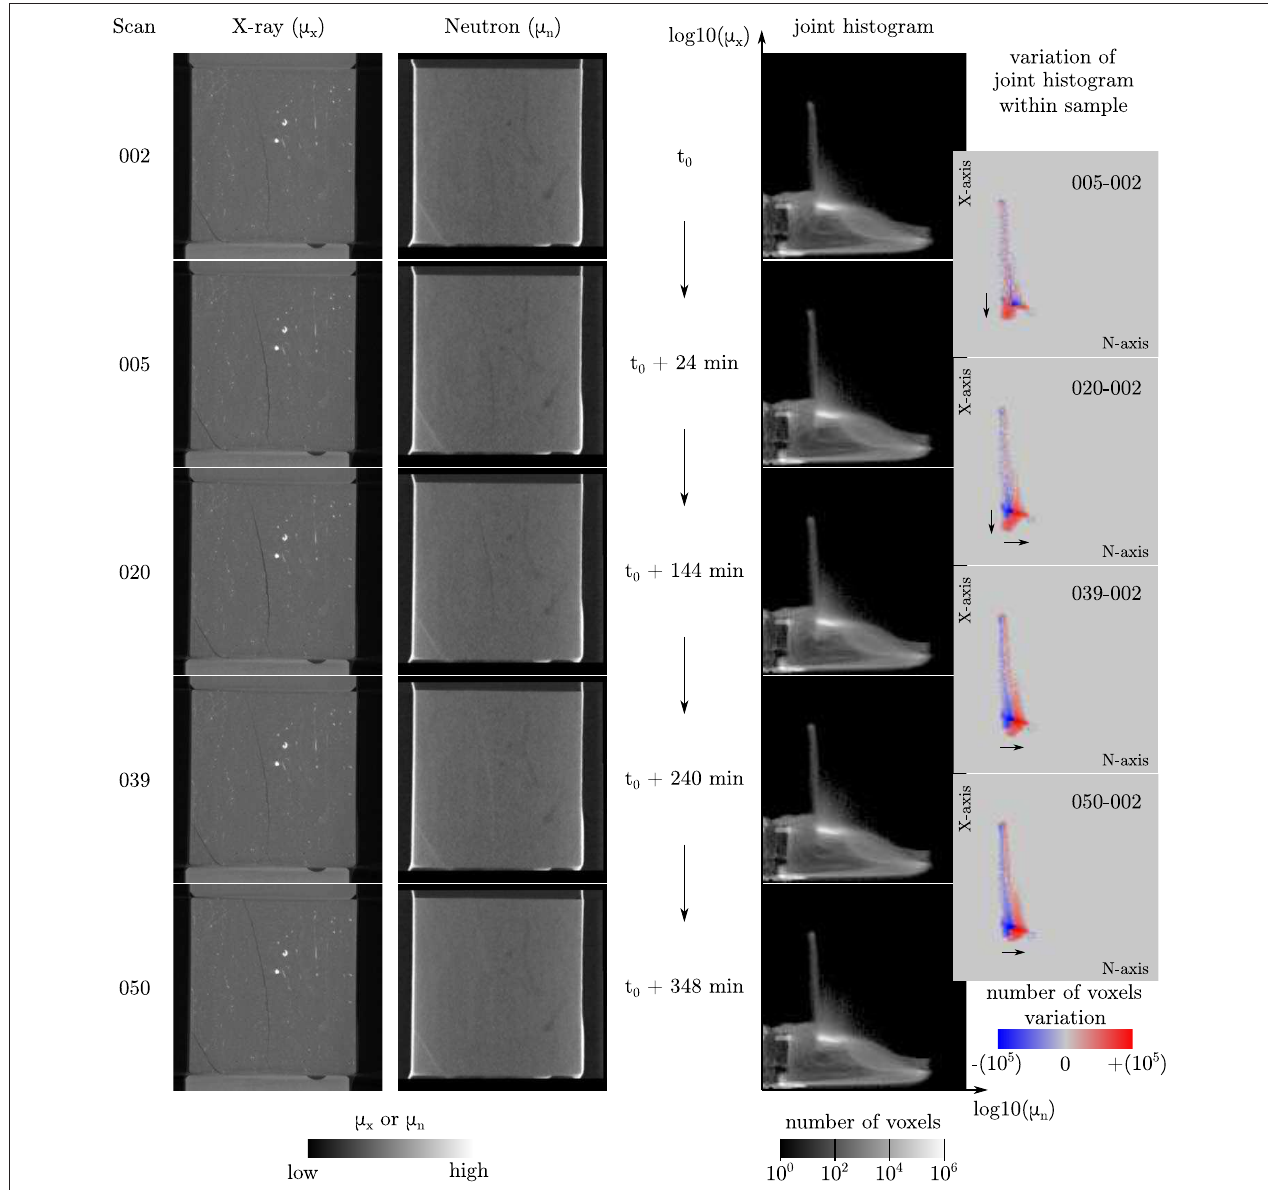
FIGURE 5 | Vertical slices through registered µ x and µ n fields throughout the wetting experiment. Slice has been chosen to be normal to the main crack present since the beginning of the experiment in the specimen. As per Figure 3 , the greylevels shown are [0–42,000] for µ x and [0-52,000] for µ n . As per convention, dark values in the slices represent lower values. Columns 3 and 4 represent the joint histograms of the pairs of images: column 3 is the entire joint histogram of the two images, with the counts being presented in log 10 . Column 4 represents a difference in counts (also in log 10 ) from 002 on a cropped zone within the